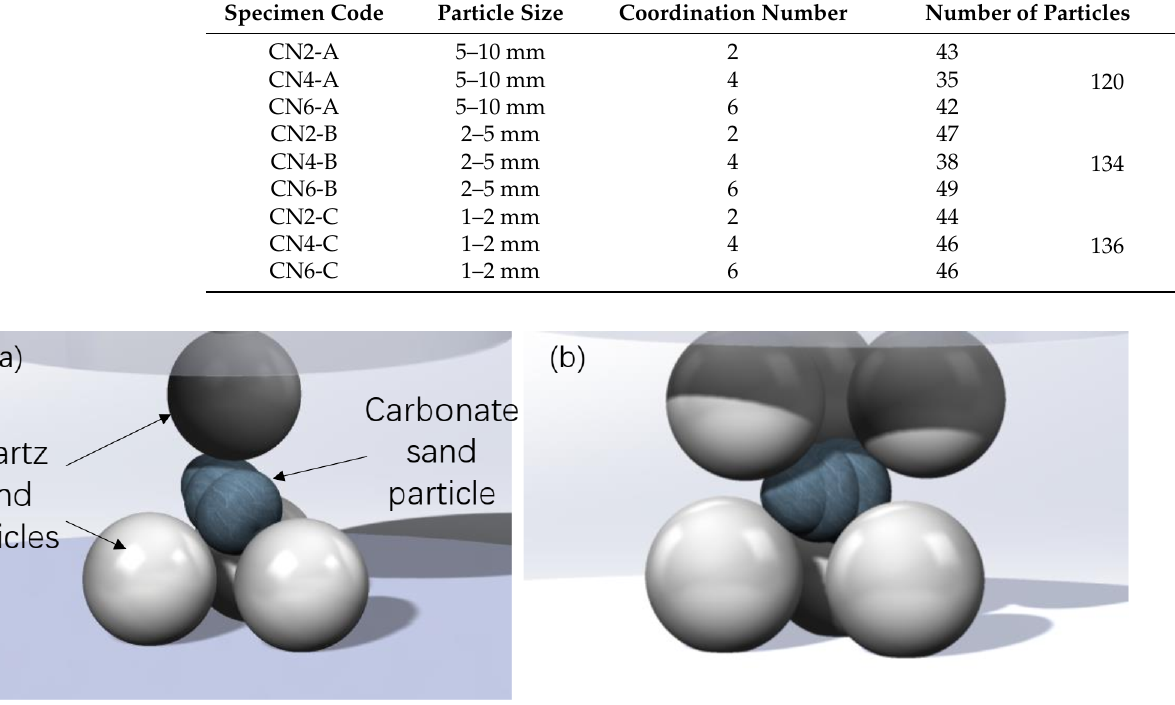
Figure 3. Schematic illustration of high coordination number test setups: ( a ) coordination number equal to 4 (CN4); ( b ) coordination number equal to 6 (CN6).